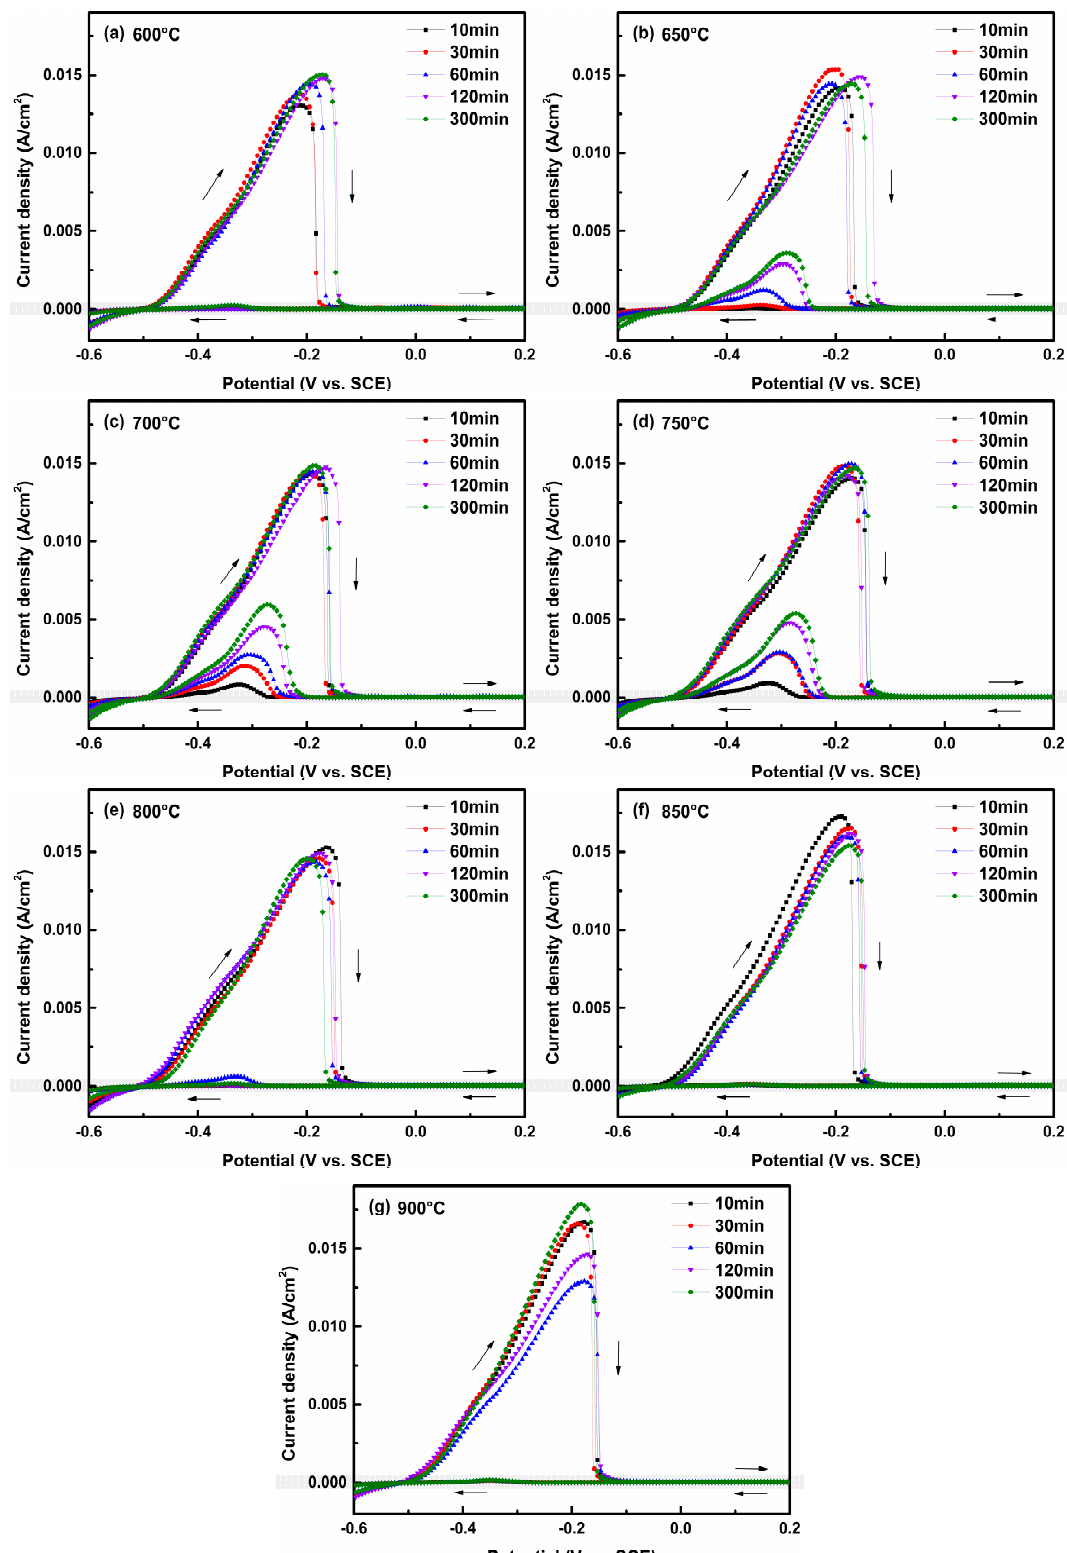
Figure 3. Double-loop electrochemical potentiokinetic reactivation (DL-EPR) test curves in a solution of 0.1 M H 2 SO 4 and 0.002 M KSCN for the Cr–Mn–Ni–N–Cu austenitic stainless steel samples aged at different temperatures for various times: ( a ) 600 °C; ( b ) 650 °C; ( c ) 700 °C; ( d ) 750 °C; ( e ) 800 °C; ( f ) 850 °C; ( g ) 900 °C. For the samples aged at 800 °C, the average R a value increased to 3.55% as the aging time